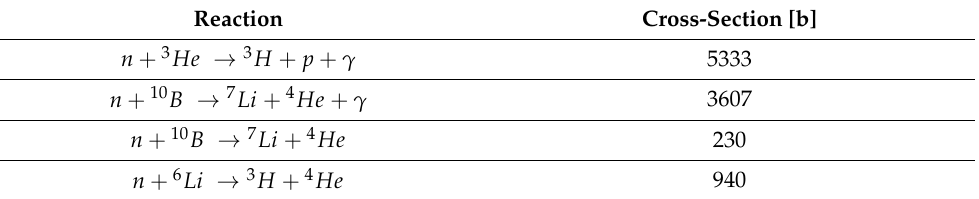
Table 1. Useful neutron conversion reactions and their respective thermal